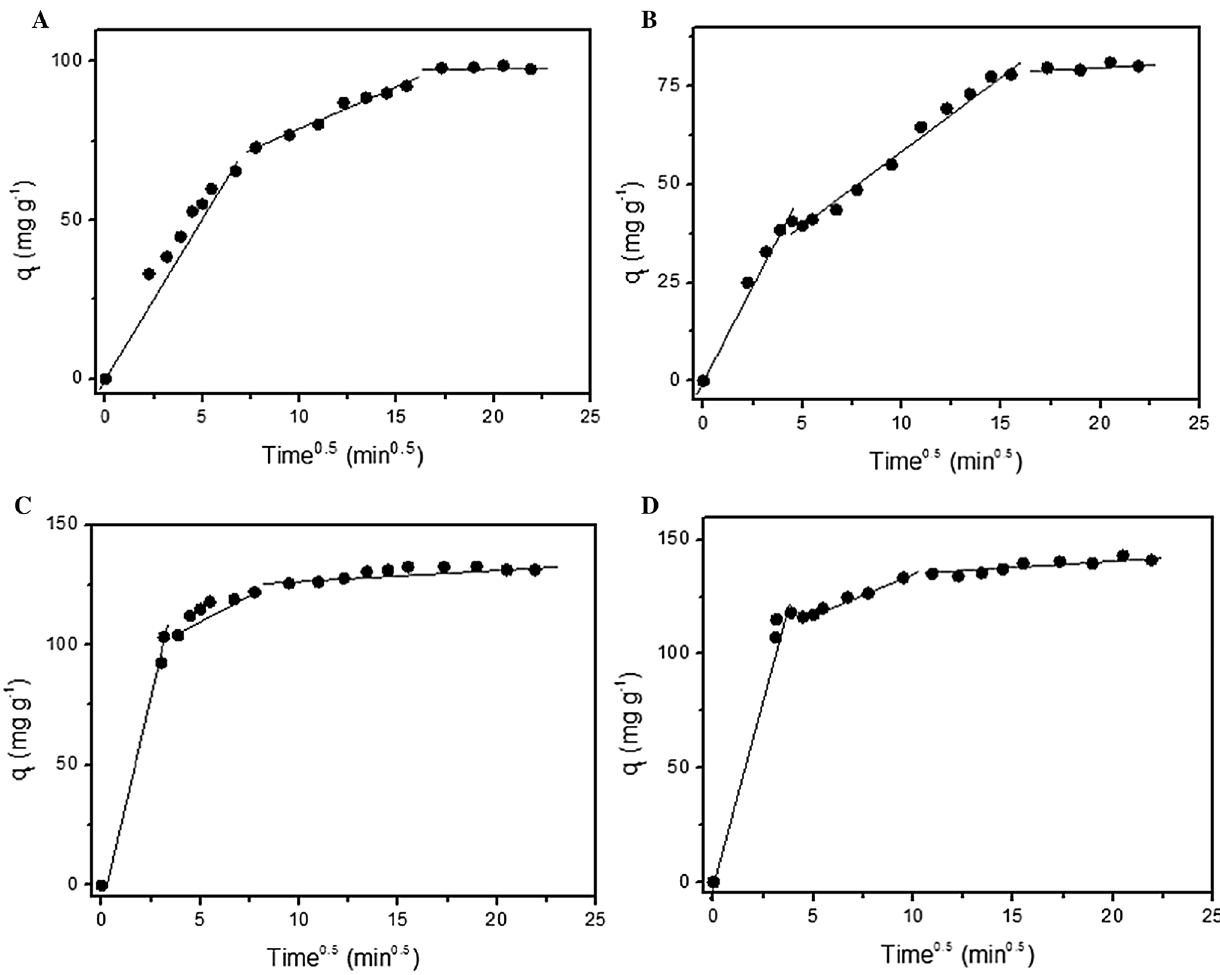
Fig. 5 Kinetic curves of intra-particle diffusion model: a 400 mg L −1 of PR-5B and CAC as adsorbent; b 600 mg L −1 of PR-5B and CAC as adsorbent; c 400 mg L −1 of PR-5B and APC-1.0 as adsorbent; and d 600 mg L −1 of PR-5B and APC-1.0 as